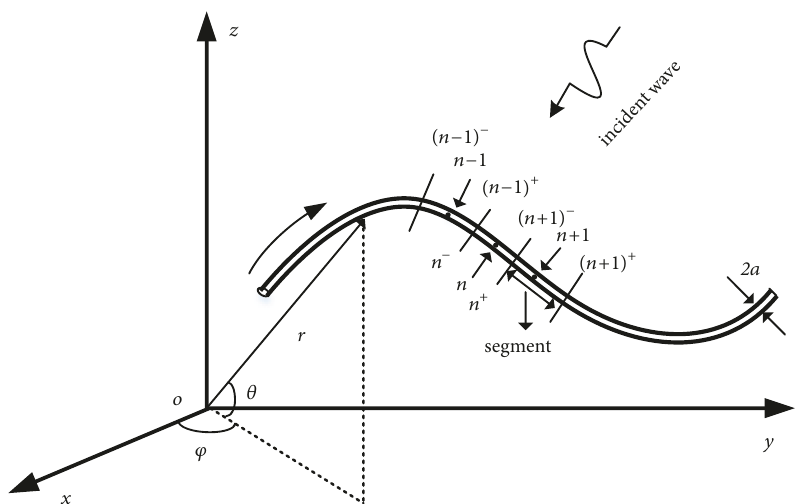
Figure 1: Thin-wire model divided into 𝑁 segments. Each segment consists of a starting point 𝑛 − , a midpoint 𝑛 , and an end point 𝑛 +